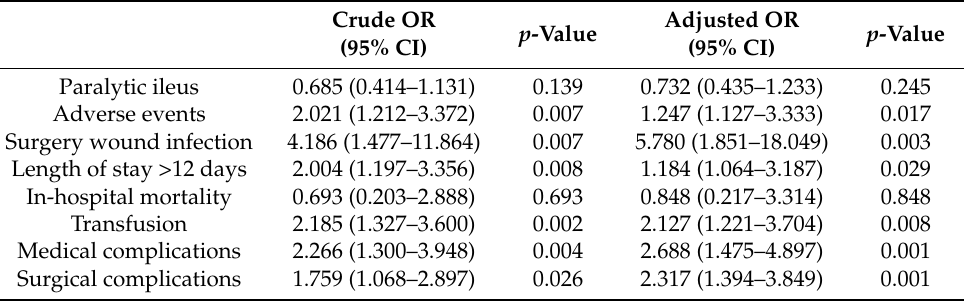
Table 3. Univariate analysis variables associated with nutritional impairment estimated by CONUT score. Crude odds ratio and Charlson Comorbidity Index and ERAS odds ratios adjusted by age and sex. Univariate analysis variables associated with nutritional impairment estimated by CONUT score at hospital